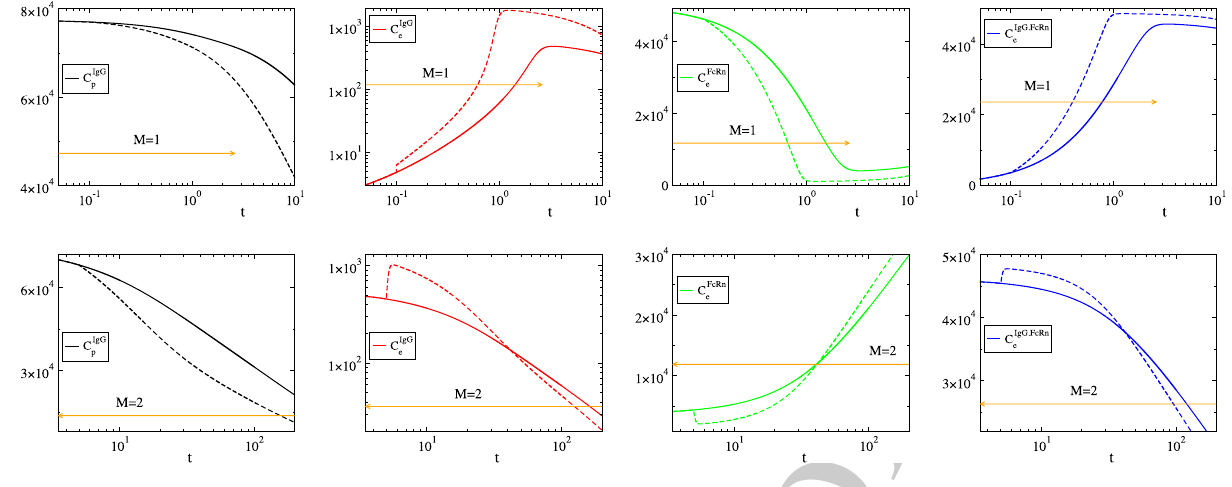
Figure 7. Concentration profiles for the reference case (parameter values in Table 1, solid curves) and for the case in which the reaction rate constant of R 1 is doubled (dashed curves). The perturbation is enforced from t = 0.1h (top) and t = 5 h (bottom). The indicated M = 1 and M = 2 periods refer to the reference case.